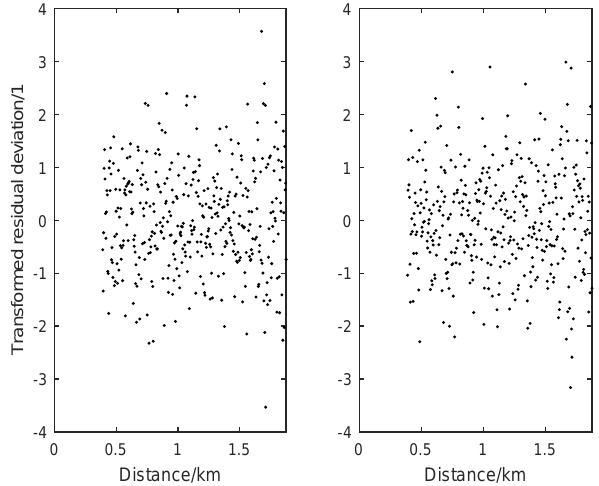
Figure 3. Residual deviations for (parts of) the measured signals shown in Fig. 1: (left) at off-resonant wavelength and (right) at on- resonant wavelength.